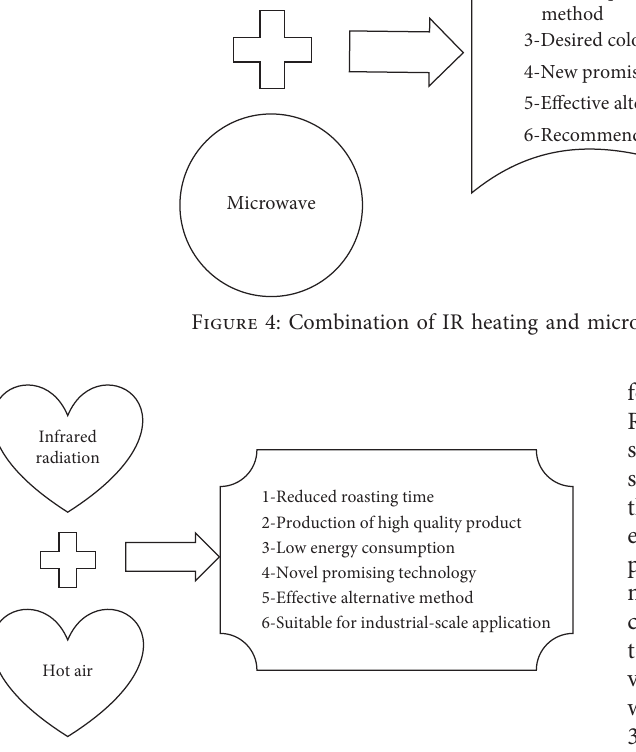
Figure 5: Combination of IR heating and hot air (IR-HA) and its